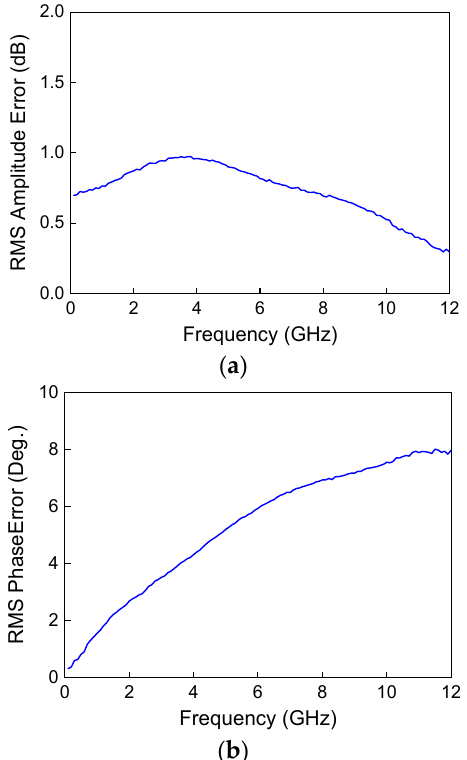
Figure 8. Measured ( a ) RMS amplitude error, and ( b ) RMS phase error of the GaN digital step attenuator MMIC. Table 2. Performance comparison of the relevant digital control step attenuators. Reference